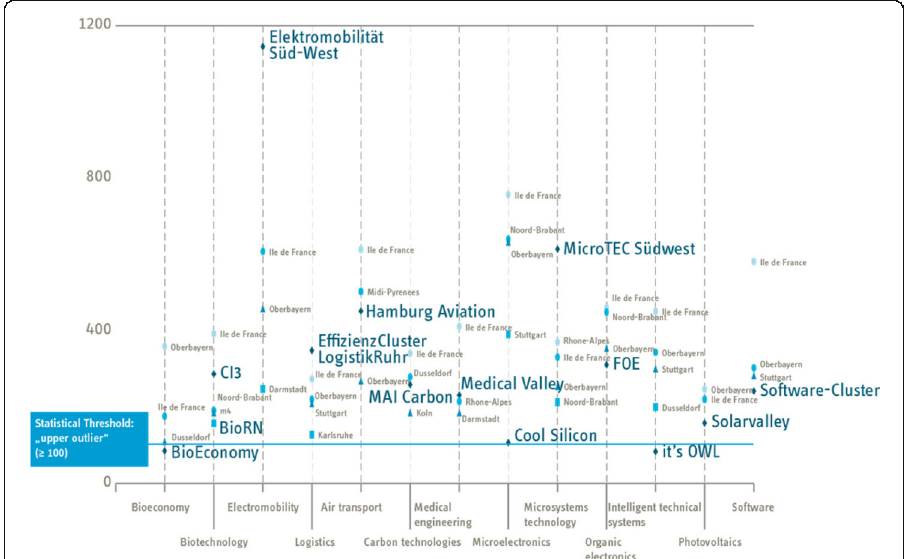
Fig. 5 EPO-patented inventions in the Leading-Edge Cluster regions in comparison with other European clusters in the relevant technology fields. Source: Accompanying evaluation of the LECC; own calculations based on data from PATSTAT and OECD-REGPAT. – Comments: Leading-Edge Cluster regions are shown as statistical outliers with regard to EPO patented inventions (to indicate technological leadership) in the relevant field of